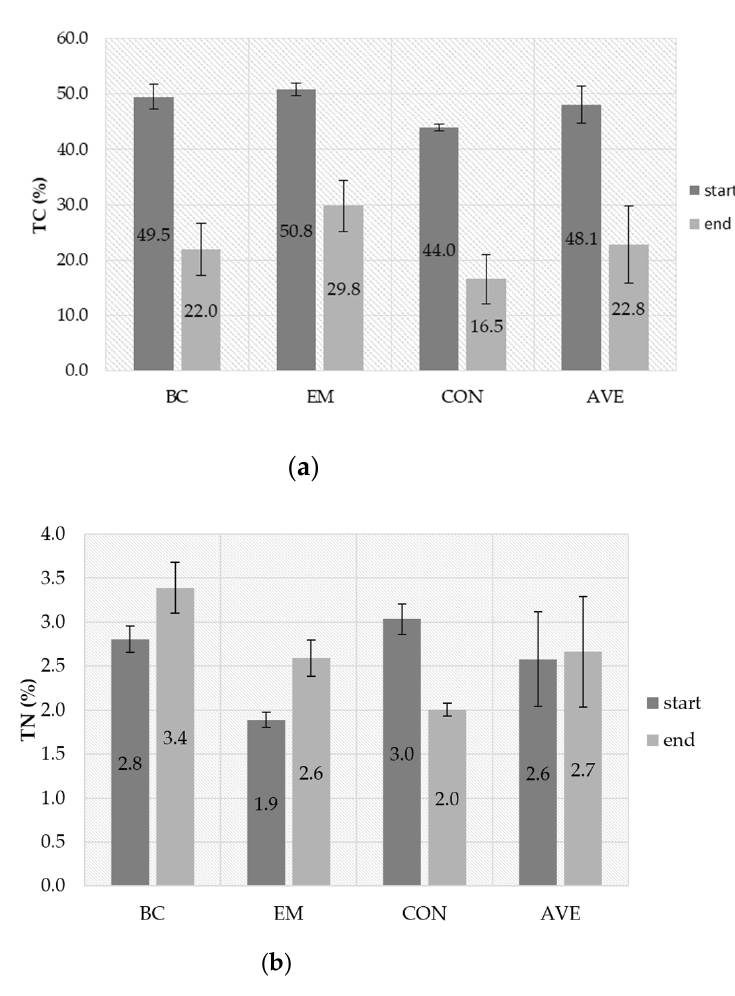
Figure 4. Mean total carbon (TC) ( a ) and mean total nitrogen content (TN) ( b ) in DM of starting material and in mature composts with standard deviation in error bars for compost piles BC, EM and CON and average (AVE).